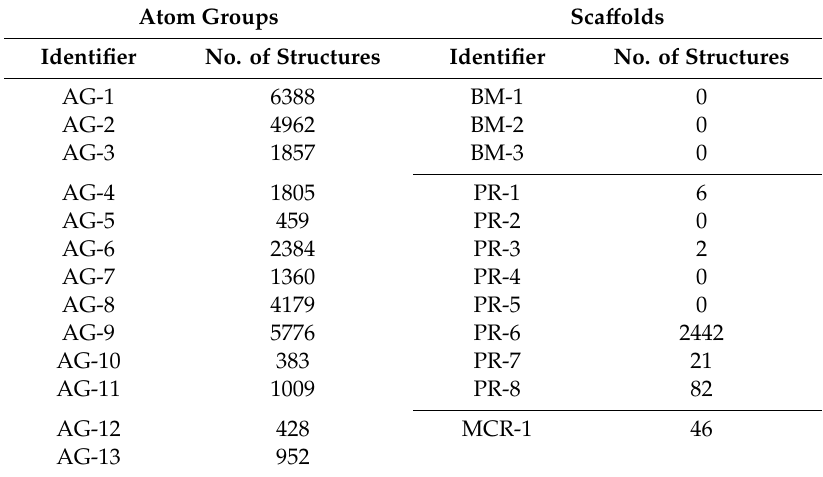
Table 3. Number of DrugBank compounds found to feature atom groups and sca ff olds previously selected in the structure–activity relationship (SAR)